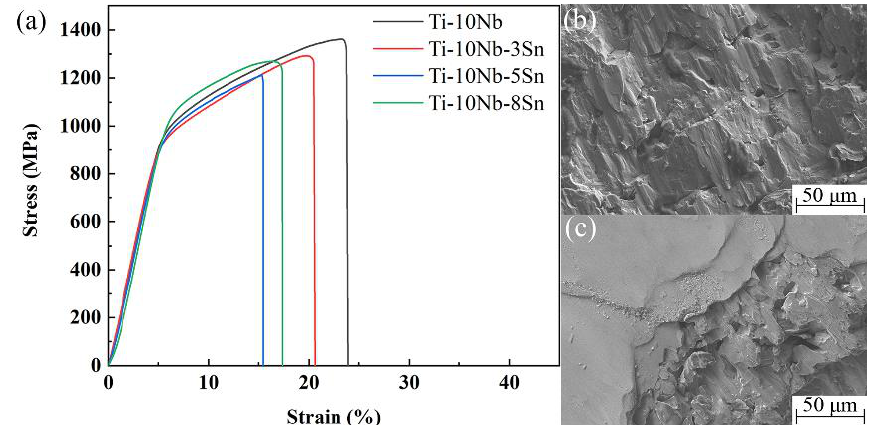
Figure 6. Compressive stress-strain curves of PM-fabricated Ti-10Nb-xSn alloys ( a ), and SEM images of fracture surface: ( b ) Ti-10Nb, ( c ) Ti-10Nb-8Sn.